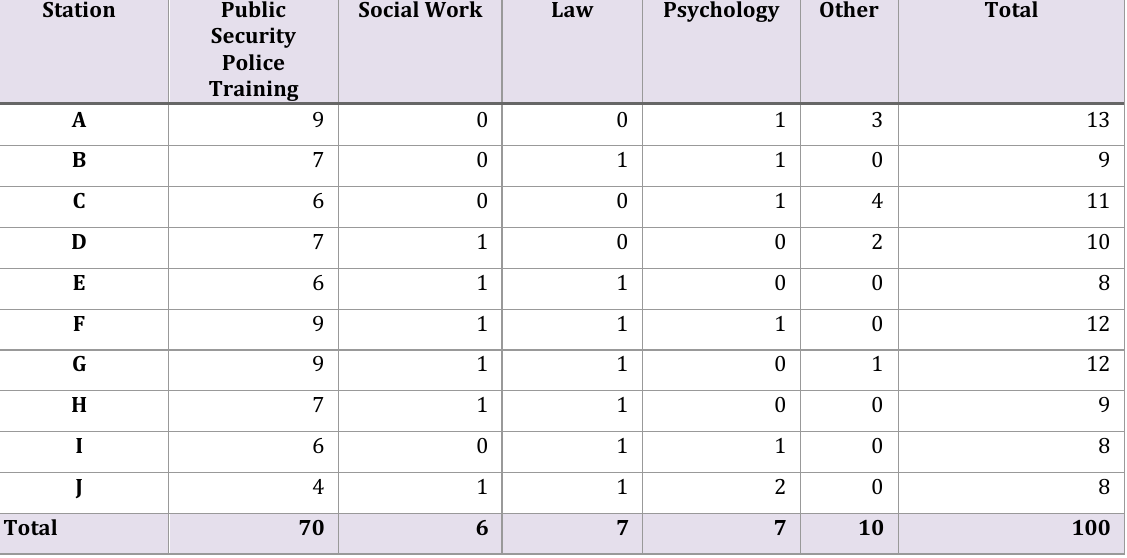
Table 3: Specialist Training to Work in W omen’s Police Stations